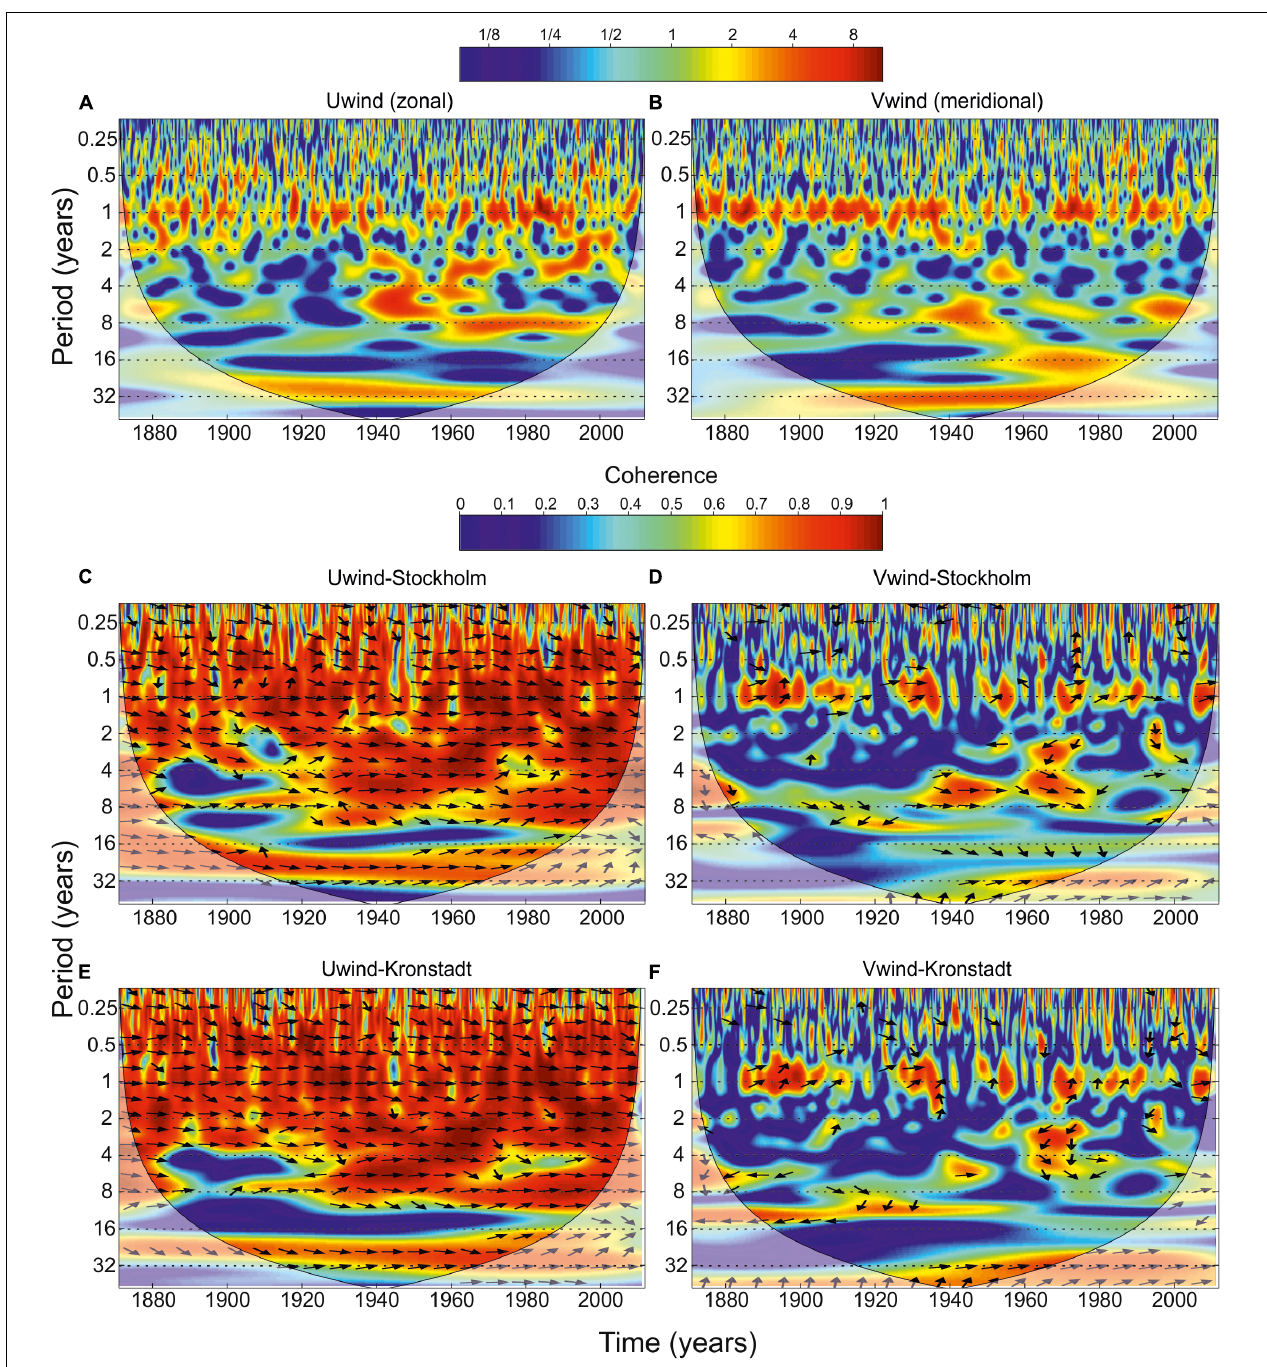
FIGURE 5 | Wavelet power spectrum (Morlet) of mean monthly values of (A) zonal and (B) meridional components of wind speed from the 20th Century Reanalysis. Contours are in variance units. The color bar represents normalized variances. Wavelet coherence and the phase difference between (C) zonal wind – Stockholm, (D) meridional wind – Stockholm, (E) zonal wind – Kronstadt, and (F) meridional wind – Kronstadt. Contours are wavelet squared coherencies. The vectors indicate the phase difference. In all panels, the black thin line is the cone of influence where edge effects might distort the picture is shown as a lighter shade.